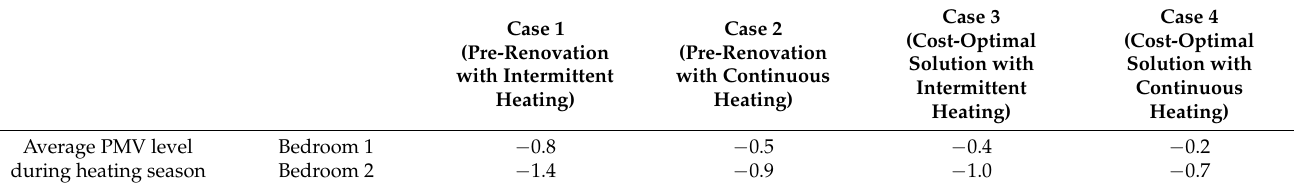
Table 8. Average PMVs in the bedrooms during the heating season.